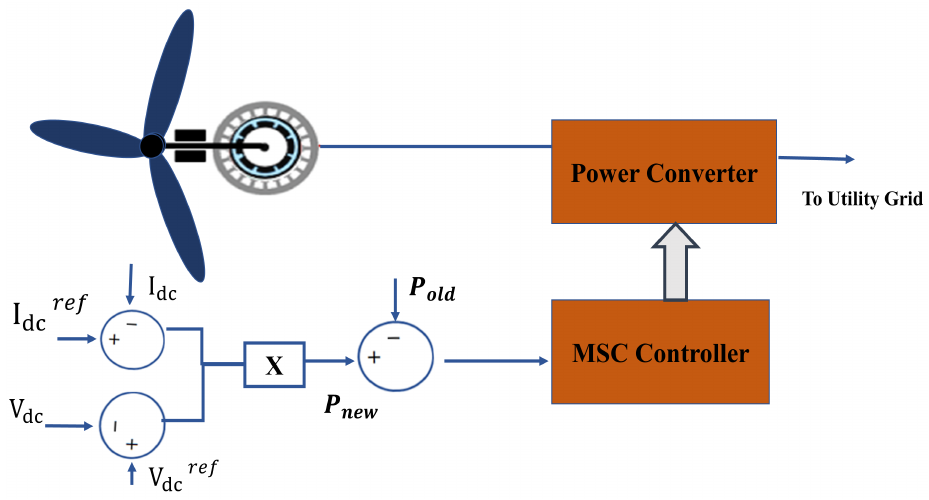
Figure 14. INC MPPT